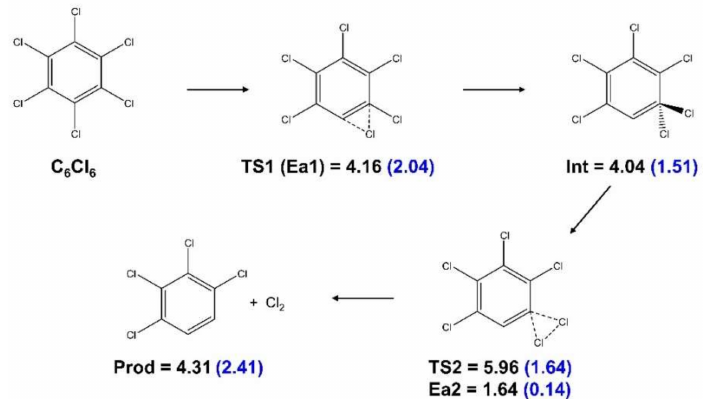
Figure 3. Minimal energy reaction pathway for the detachment of Cl 2 and Cl 2 − from ortho sites in C 6 Cl 6 . Energies in eV. The values in parenthesis are for the anionic